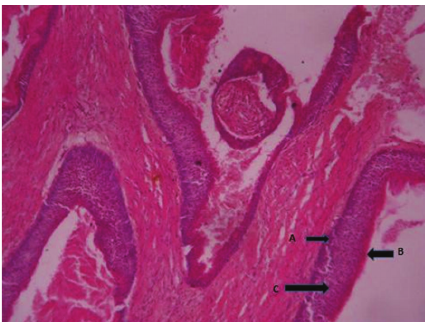
Figure 7: Sagittal CT showing involvement of the roof of the base of the skull.